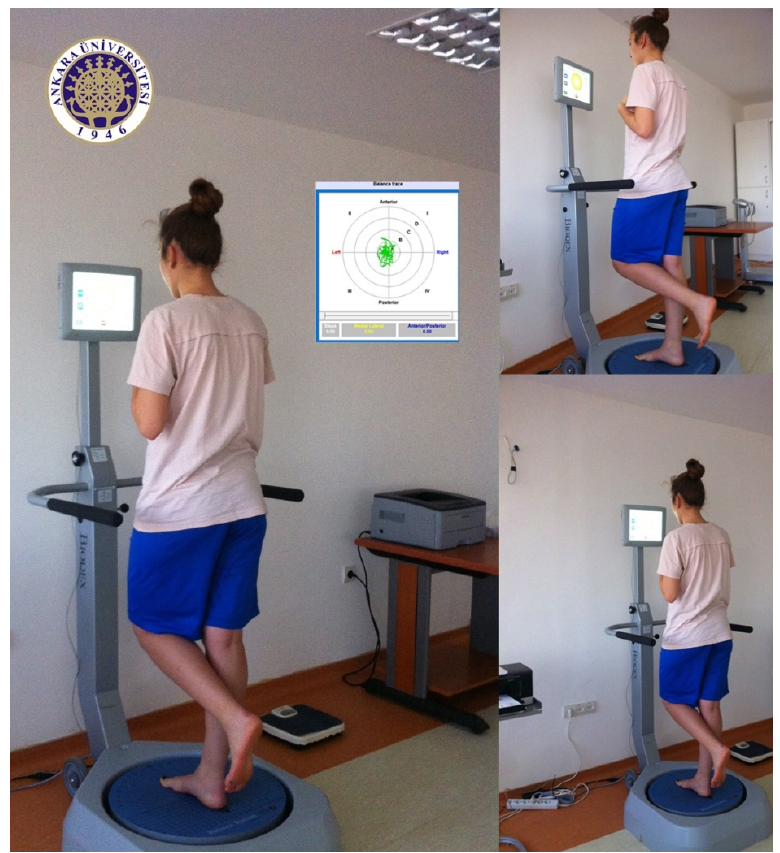
Figure 1. One subject during the data collection phase. Female soccer player.